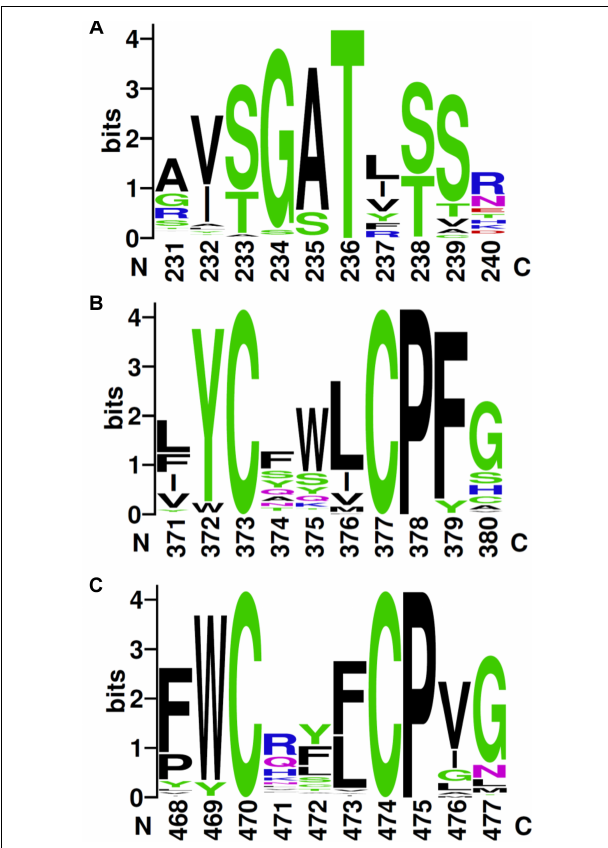
FIGURE 3 | Conserved sequence motifs in RdhC family. Based on the alignment of the 117 RdhC non-redundant representative sequences, motifs were drawn using Weblogo: (A) the FMN-binding motif, with the fully conserved threonine involved in binding FMN covalently; (B,C) the two CX 3 P signatures. Residue numbering follows the alignment.